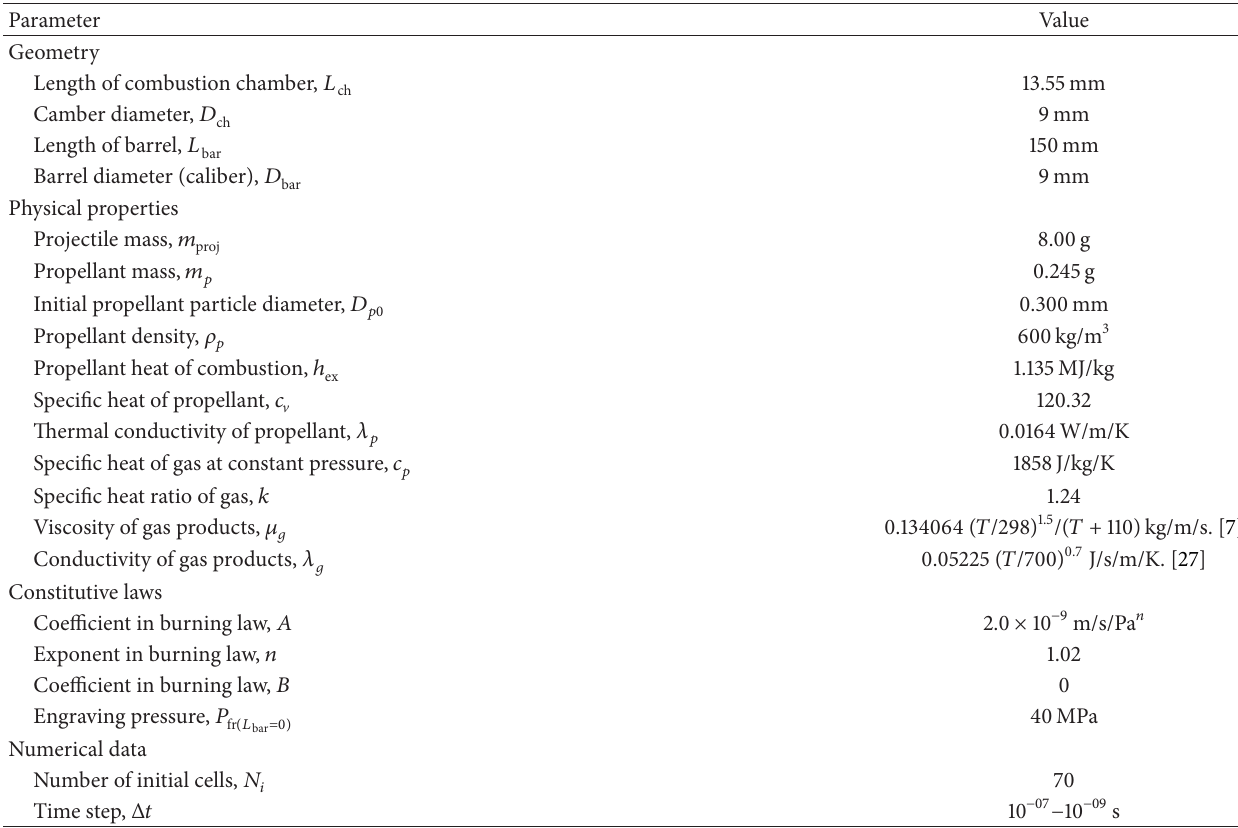
Table 1: Materials properties and operating conditions.